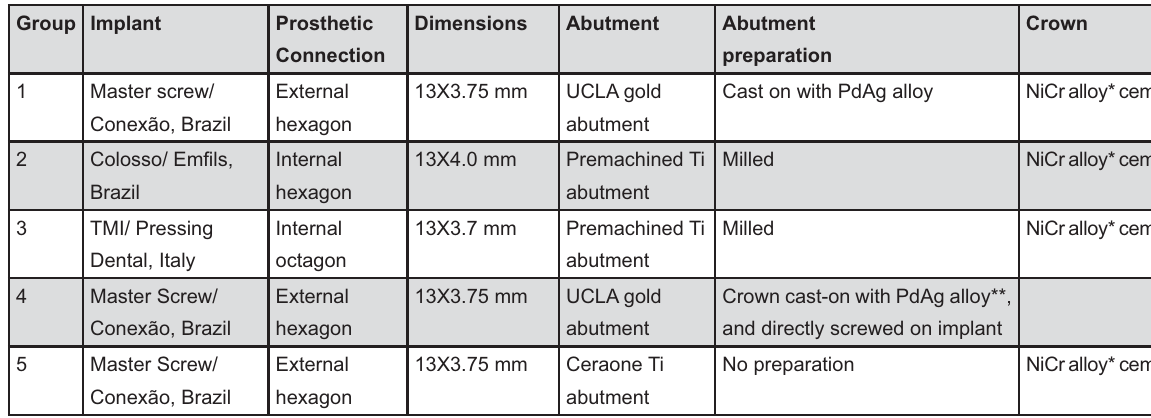
Figure 1- Five groups of implant systems used in this